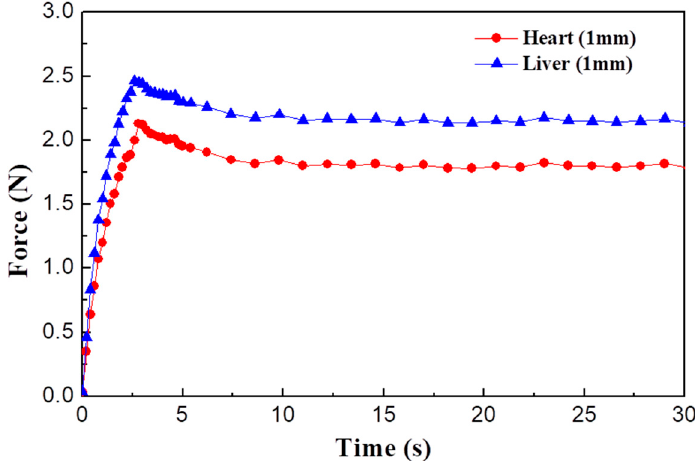
Figure 4. Force levels of two specimens.